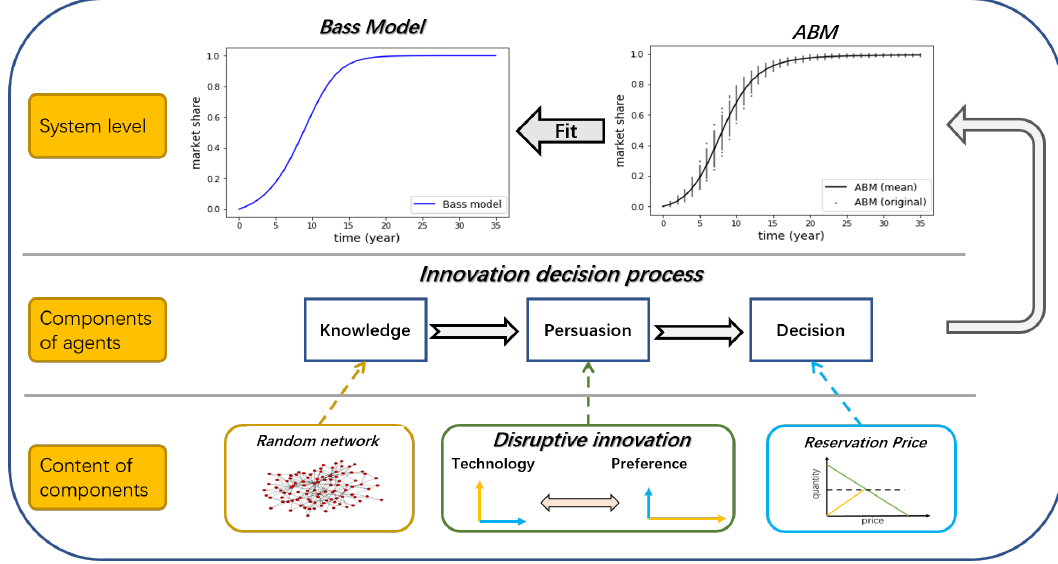
Figure 2. The framework of the agent-based model